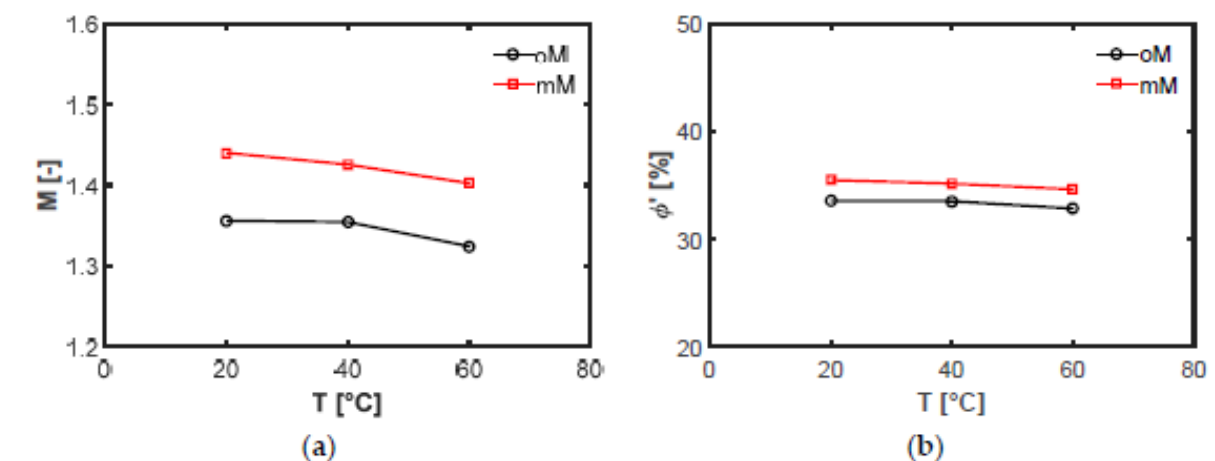
Figure 13. Temperature variations of: ( a ) slopes M of the p (cid:48) – q diagrams at failure; ( b ) effective internal friction angles φ (cid:48) , of the two till